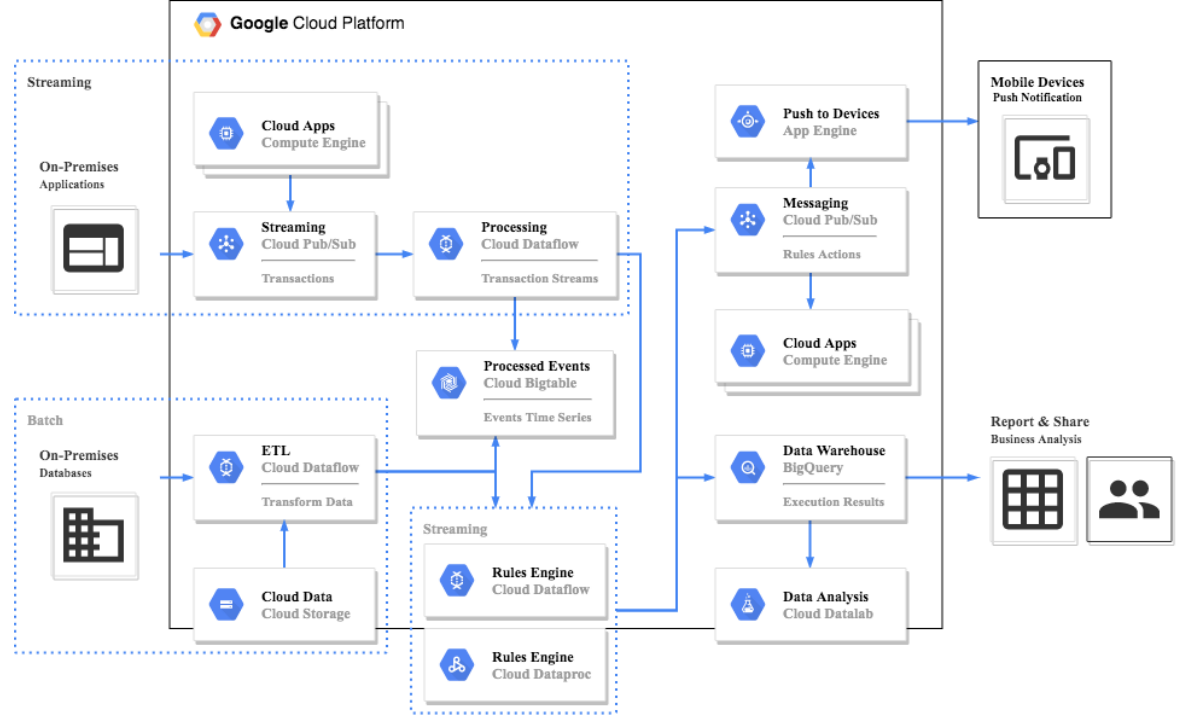
Figure 3. Basic architecture of Google Cloud Computing Platform for mounting applications and programs on top of it.